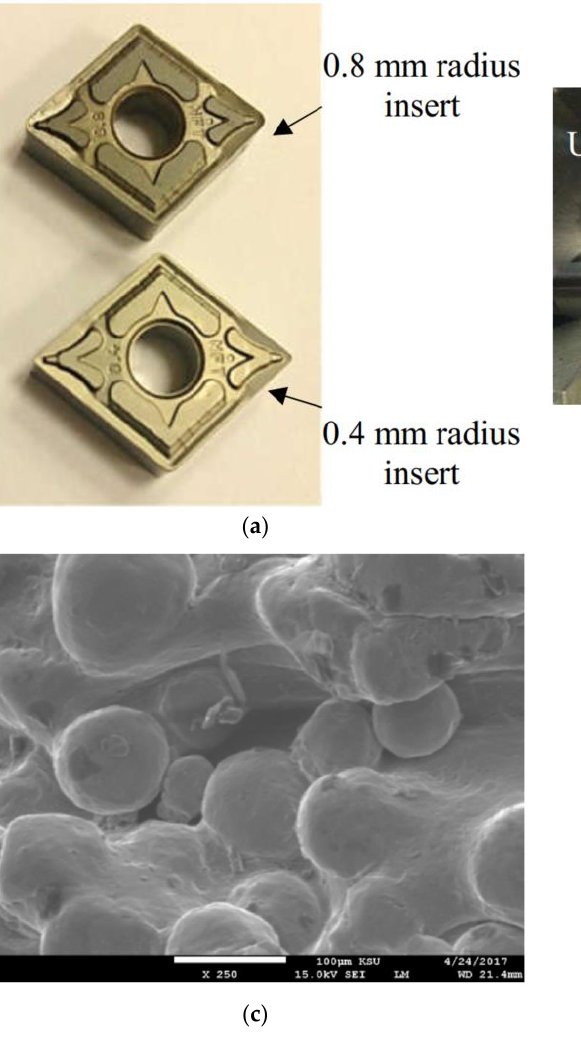
Figure 2. ( a ) Tungsten carbide cutting inserts for turning, ( b ) clamped γ-TiAl cylinder on the chuck during turning experimentation, ( c ) SEM photograph of un-machined EBM produced γ-TiAl cylinder, ( d ) SEM photograph of machined EBM produced γ-TiAl cylinder. Table 3. Physical properties of γ